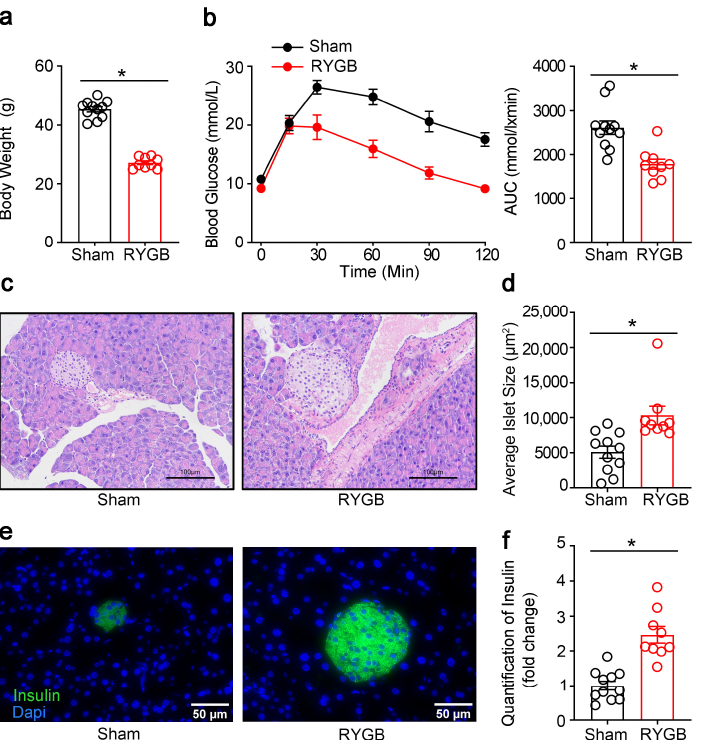
Figure 7. RYGB increased β‐ cell area in diet ‐ induced diabetic mice. ( a ) Body weight of RYGB ‐ treated diabetic mice. ( b ) Intraperitoneal glucose tolerance test. ( c ) HE staining of pancreatic sections. ( d ) Quantification of islet size. ( e ) Immunofluorescence staining for insulin (green) in the pancreas from the sham ‐ operated or RYGB mice. ( f ) Quantification of insulin. The results were expressed as mean values ± SEM. ( n = 11 for sham, n = 9 for RYGB), * p < 0.05 vs. sham ‐ operated animals. In concordance with the increased β‐ cell after RYGB, decreased β‐ cells apoptosis was observed in RYGB mice, as indicated by immunofluorescence staining of CC3 and insulin (Figure 8a,b). Moreover, immunofluorescence staining for fatty acid synthase (FASN) showed a decline in the expression of FASN in the β‐ cells in RYGB mice (Figure 8c,d), suggesting a downregulation of lipogenic pathway in β‐ cells after RYGB.